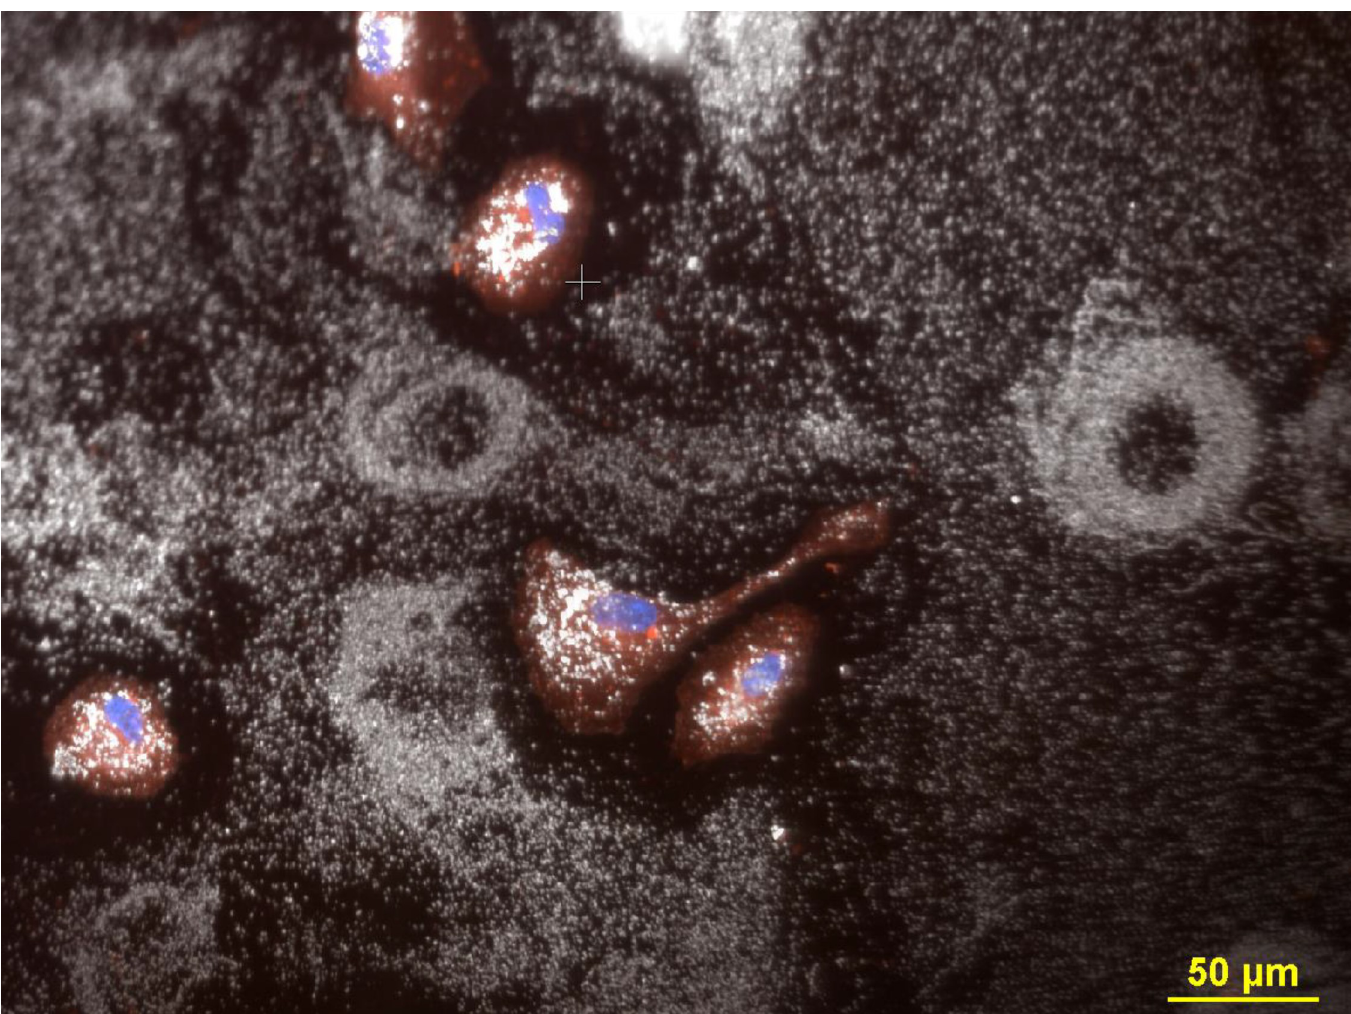
Fig 13. ARPE-19 cells incubated with 10 μ g/ml AgNP citrate. The cells were transfected with mitochondria-GFP (green), stained with CellMask Orange plasma membrane stain (C10045, red), fixed with 4% PF, and mounted with Prolong gold that contained DAPI to stain the nuclei (blue). Field shows a dense accumulation